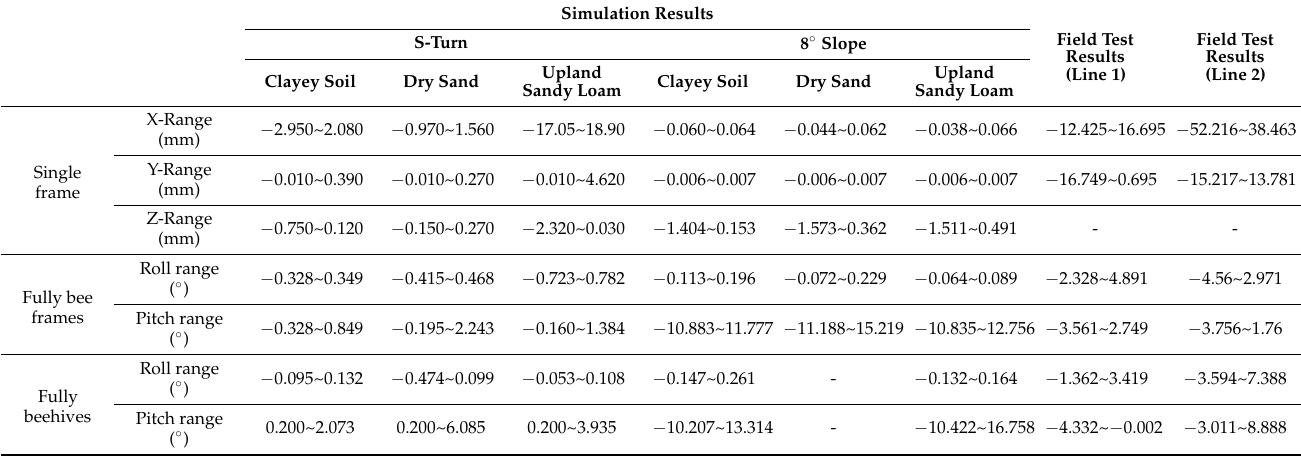
Table 4. Summary of the simulation and field test